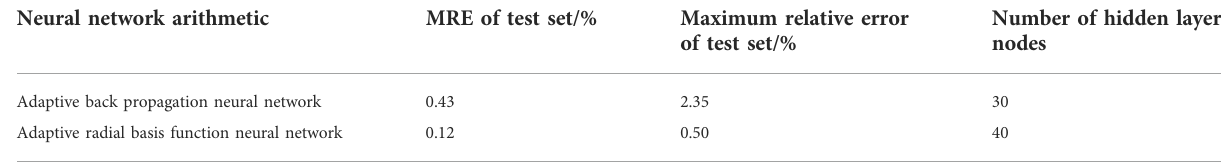
TABLE 2 Comparison of neural network forecast